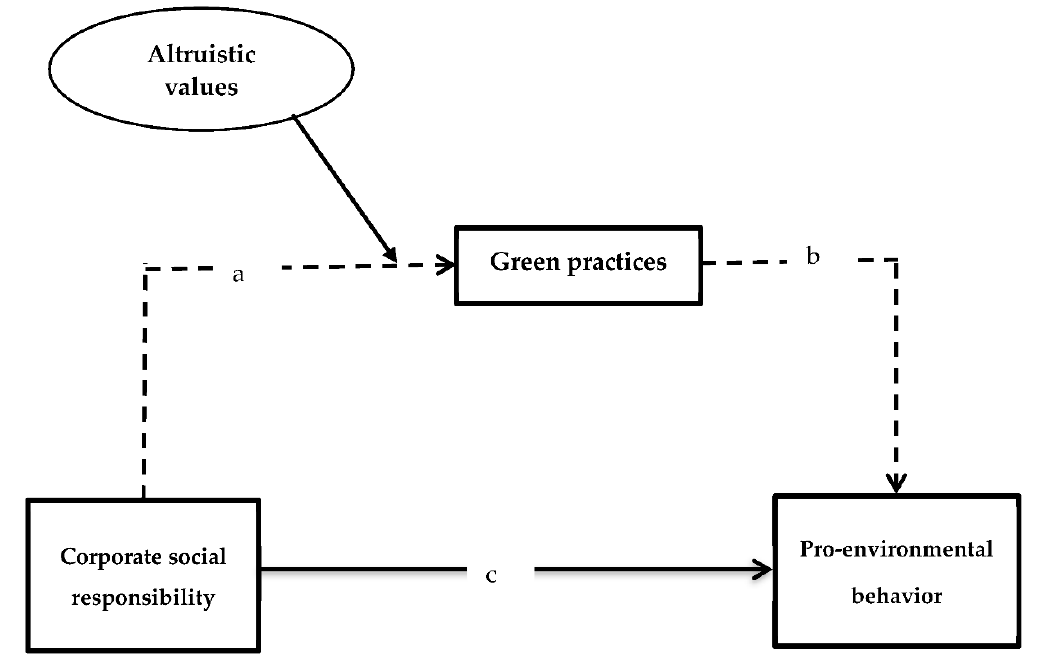
Figure 1. Hypothetical model of this study. Note: a,b, c shows the direction of variables.